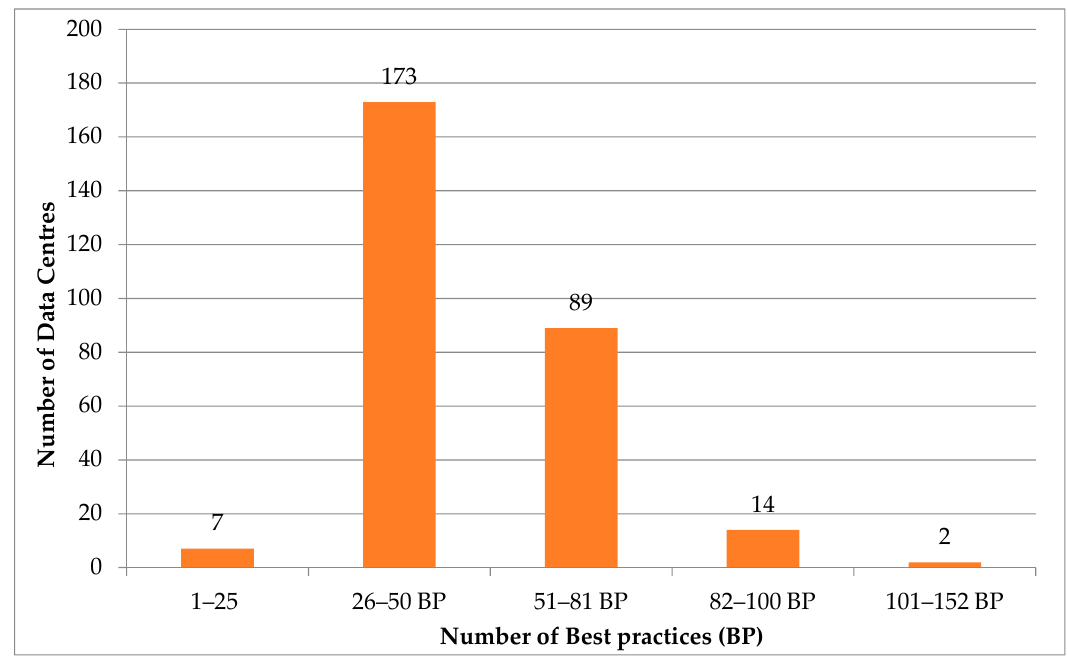
Figure 9. Frequency of the best practices implementations.